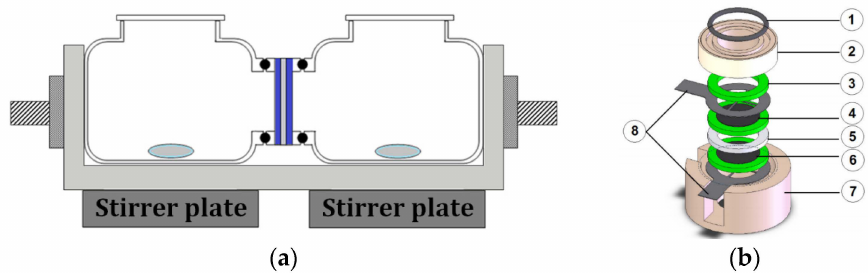
Figure 5. ( a ): separator characterization setup; ( b ): electrode assembly holder used for the ionic resistivity tests, (1) O-ring; (2) holder top; (3) gasket; (4) cathode electrode; (5) separator; (6) anode electrode; (7) holder base; (8) current collectors